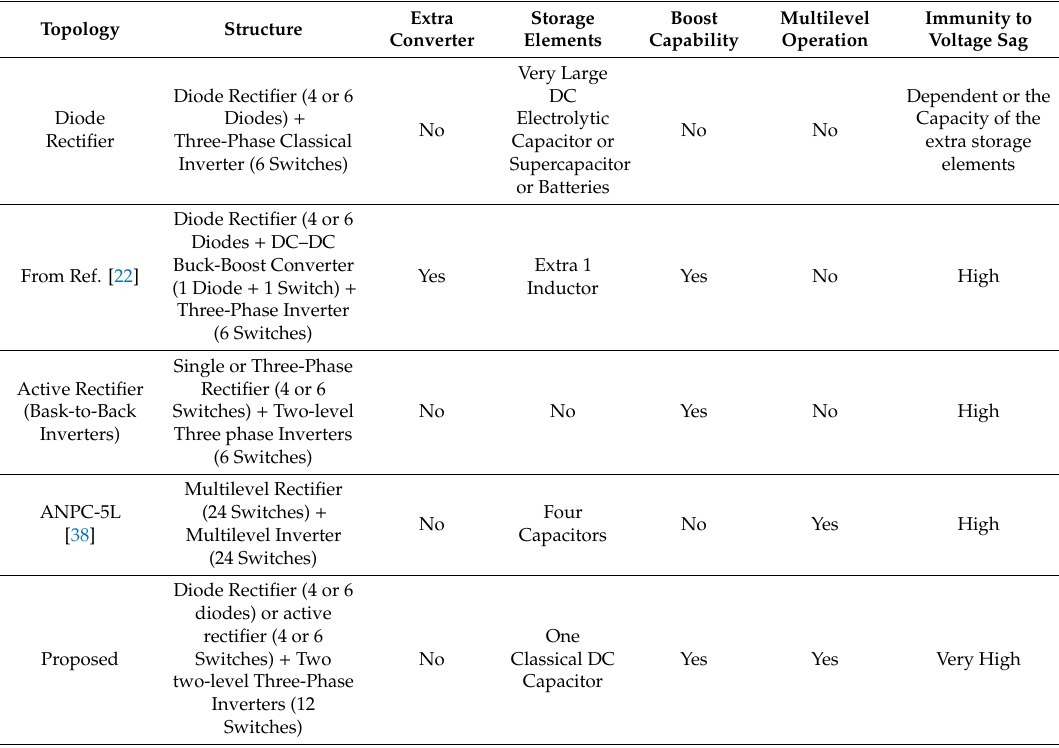
Table 1. Summary of several